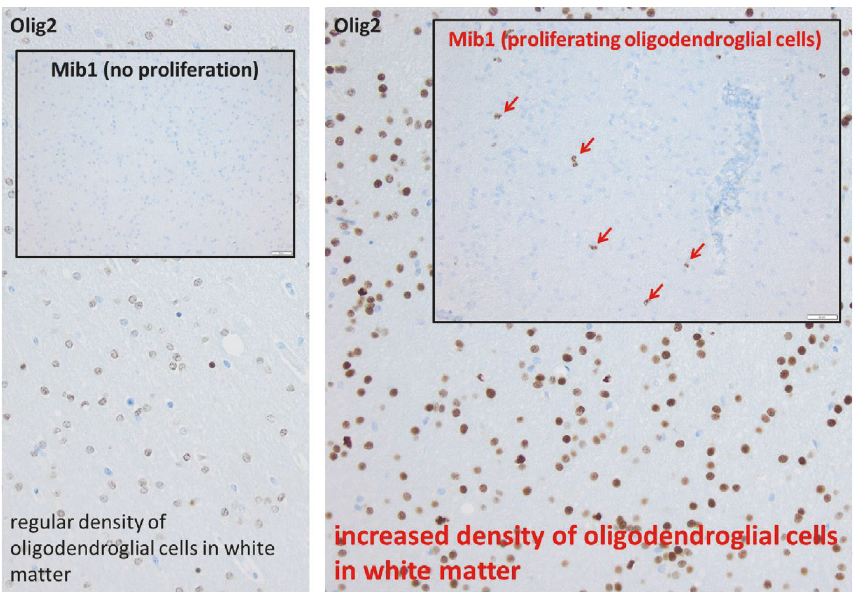
Figure 5: MIB1 (Ki67) immunohistochemistry (proliferating cells are